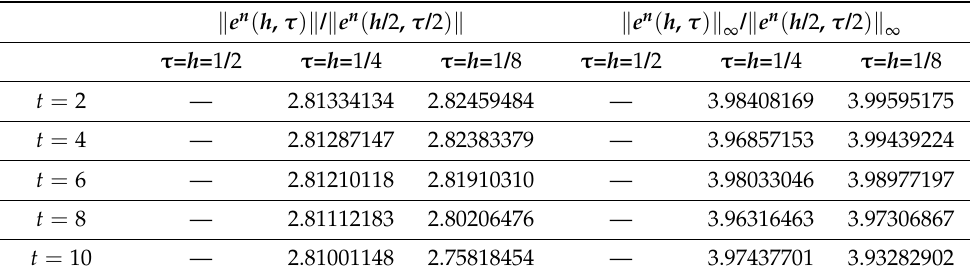
Table 2. The convergence rateswith various h and τ and various norms.